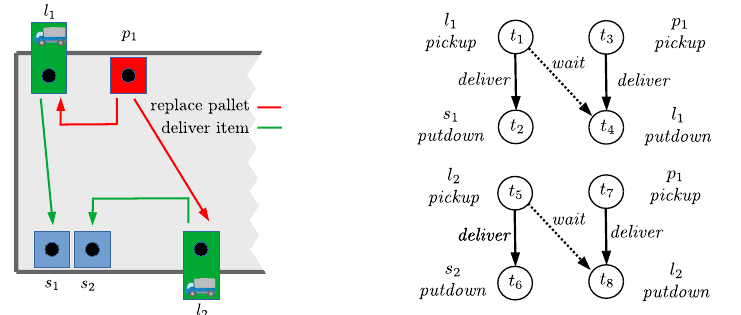
Figure 2. Item deliveries from l 1 to s 1 and from l 2 to s 2 . Their corresponding replacement empty pallet deliveries are from p 1 to l 1 and l 2 ,